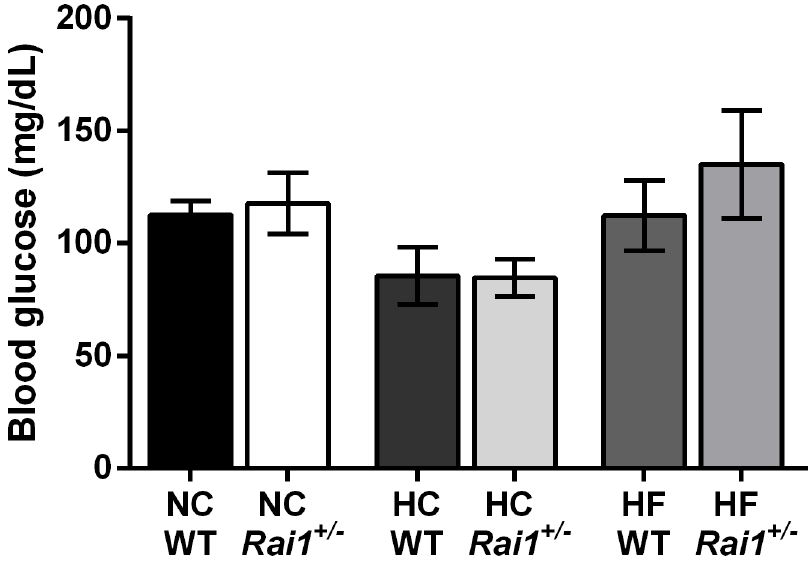
Figure 4. Blood glucose levels are not altered due to diet regimens. Mice fed either normal chow, high carbohydrate, or high fat do not have altered blood glucose levels after 12 hours of fasting. All data are plotted as mean + / 2 SEM. NC: WT n=5, Rai1 + / 2 n=8. HC: WT n=3, Rai1 + / 2 n=7. HF: WT n=3, Rai1 + / 2 n=5.